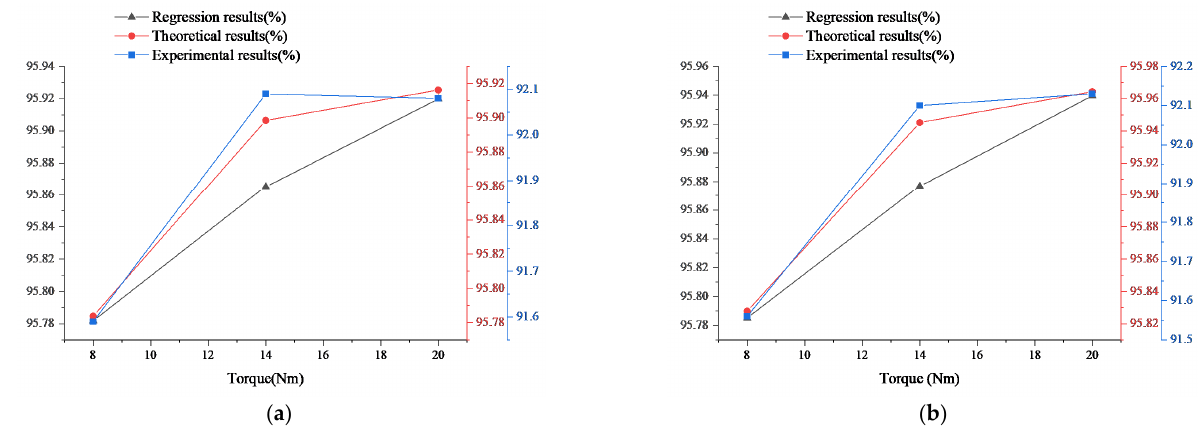
Figure 7. Results and comparison with other methods: ( a ) gear data: z 1 = 30, u = 1, α w = 20°, m = 2.5 mm, b w = 24 mm, n = 200 rpm, β = 0°, R a = 1.6 µm.; ( b ) gear data: z 1 = 20, u = 2, α w = 20°, m = 2.5 mm, b w = 24 mm, n = 200 rpm, β = 0°, R a = 1.6 µm.